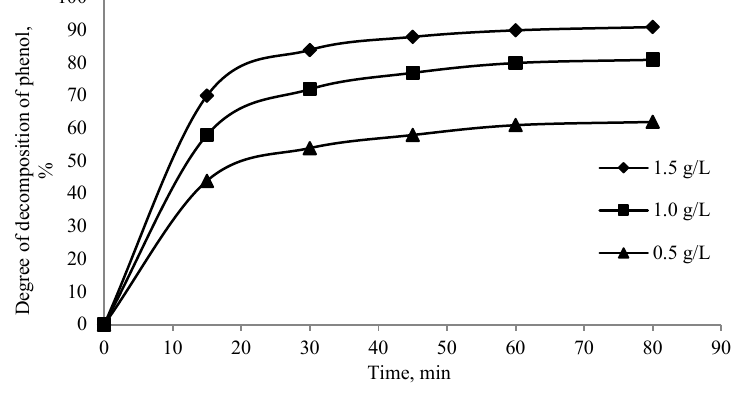
Fig. 10. Dependence of the degree of decomposition of phenol in water on the concentration of encapsulated sodium ferrate and time. The curves show that after 10 minutes of contact of the encapsulated ferrate with the solution the maximum degree of decomposition of phenol in water is almost reached. Further, the decomposition proceeds at a low rate, and reaches 90 % at a concentration of encapsulated sodium ferrate in a solution of 1.5